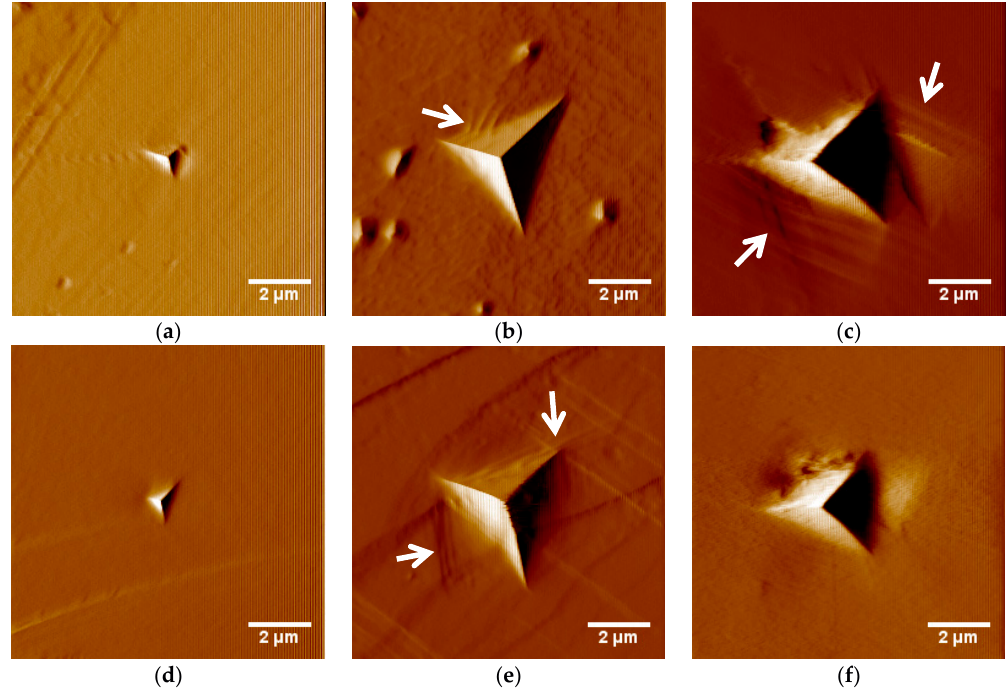
Figure 4. Scanning probe images (in deflection mode using the Hysitron Triboindenter imaging mode, which are therefore indicative of slope, not height, to accentuate small surface topography changes) of ( a ) 500 μ N Berkovich indent on idoxuridine, ( b ) 5000 μ N Berkovich indent on idoxuridine, ( c ) 5000 μ N cube corner indent on idoxuridine, ( d ) 500 μ N Berkovich indent on HMX, ( e ) 5000 μ N Berkovich indent on HMX, and ( f ) 5000 μ N cube corner indent on HMX. Slip steps are evident in ( b , c , e ) (noted with arrows), but it is not possible to conclusively state if cracks are present in some of the images, such as the dark band in the lower left of ( c ).